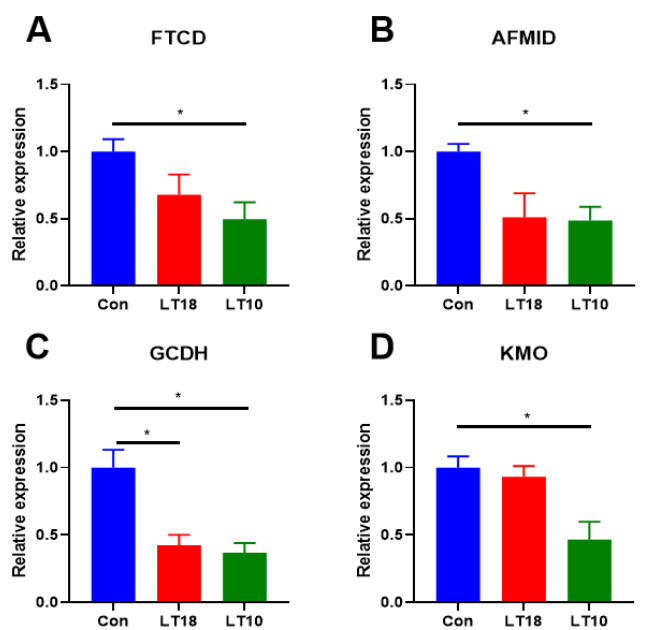
Figure 5. Expression of the amino acid metabolism-related key genes in freshwater drums liver induced by 2 days cold stress ( n = 9): ( A ) formiminotransferase cyclodeaminase, FTCD; ( B ) enzyme arylformamidase, AFMID; ( C ) glutaryl-CoA dehydrogenase, GCDH; ( D ) kynurenine3- monooxygenase, KMO. Asterisk represents the statistical difference (*, p <0.05).